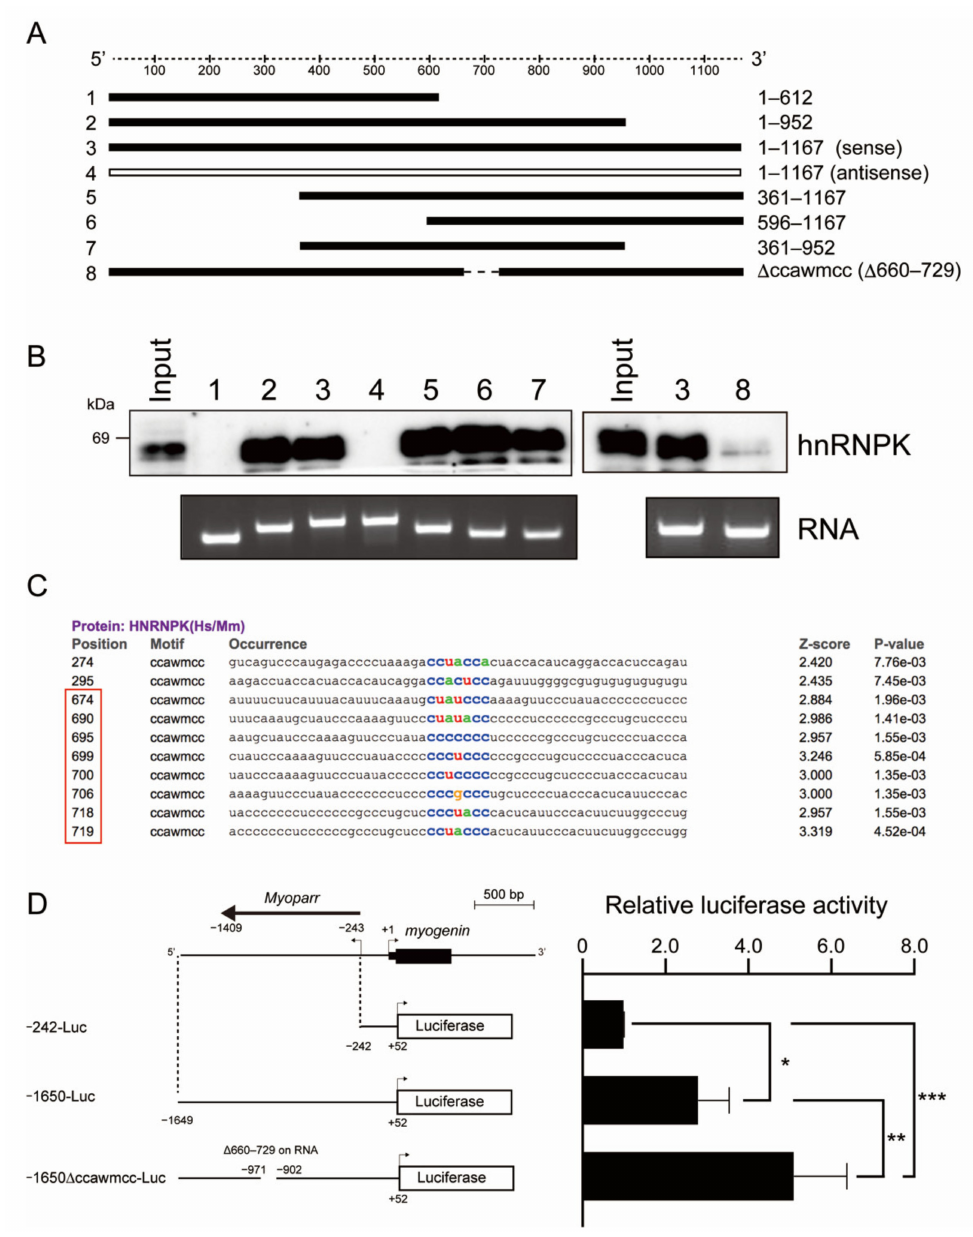
Figure 3. The hnRNPK region on Myoparr is required for repression of myogenin promoter activity. ( A ) A schematic diagram of various lengths of Myoparr used for RNA pull-down assays. ( B ) In vitro transcribed/translated hnRNPK protein was pulled down by Myoparr and then detected by western blotting using an hnRNPK-specific antibody. Lane numbers are consistent with ( A ). The RNA lanes indicate various forms of Myoparr used for RNA pull-down. ( C ) The results of an RBPmap analysis searching the motif of hnRNPK. Colored letters correspond to the hnRNPK motif. The red frame indicates the ccawmcc motifs within the region deleted in ∆ ccawmcc, #8 in ( A ). ( D ) The left panel shows a schematic diagram of the constructs used for the luciferase assays. − 242-Luc contains the myogenin promoter region. − 1650-Luc contains both the myogenin promoter region and Myoparr . − 1650 ∆ ccawmcc-Luc contains the myogenin promoter region and Myoparr without the ccawmcc motifs, corresponding to #8 in A. The right panel shows the relative luciferase activities of indicated constructs in differentiating C2C12 cells. n = 4, mean ± SD. *** p < 0.001, ** p < 0.01, * p <